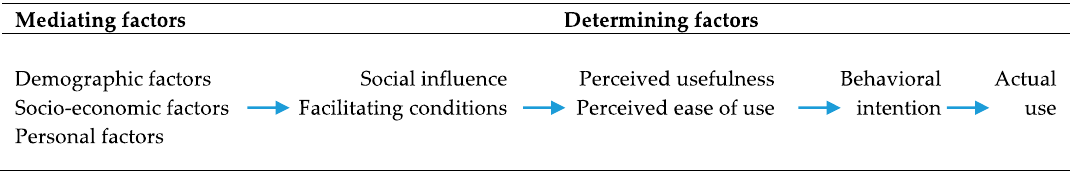
Figure 3. The main variables of the Mobile phone technology acceptance model (MOPTAM), adapted after [27].